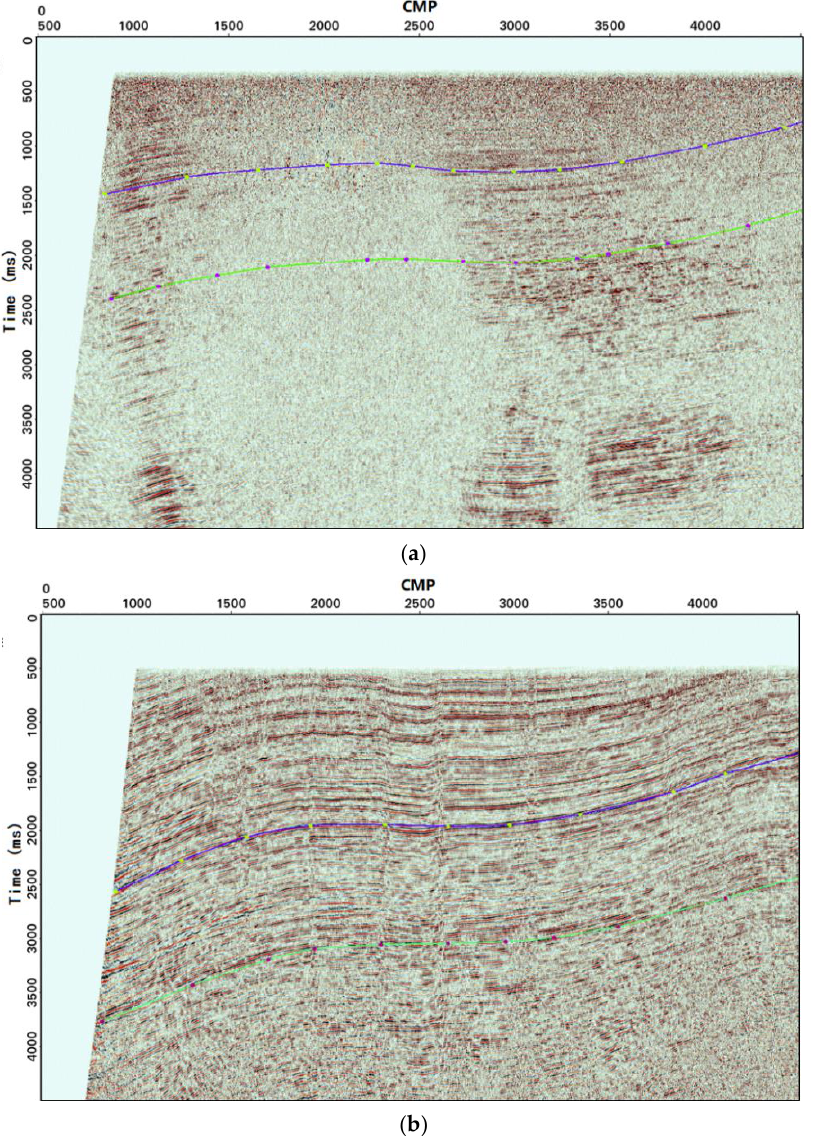
Figure 7. Pre-stack time migration (PSTM) sections: ( a ) P-wave and ( b ) SH shear wave. For ease of understanding, we built a flow chart of velocity modeling, as shown in Figure 9. Figure 9 is about the P wave and SH shear wave velocity modeling process in this paper. In this figure, for the convenience of display, the S wave means SH shear wave. We can see that, after the preliminary modeling, we need to go through layer-based tomography and grid-based tomography, and the velocity ratio is obtained simultaneously with the velocity modeling. After the velocity ratio is obtained, it is used to constrain the velocity model of P wave to get the accurate velocity